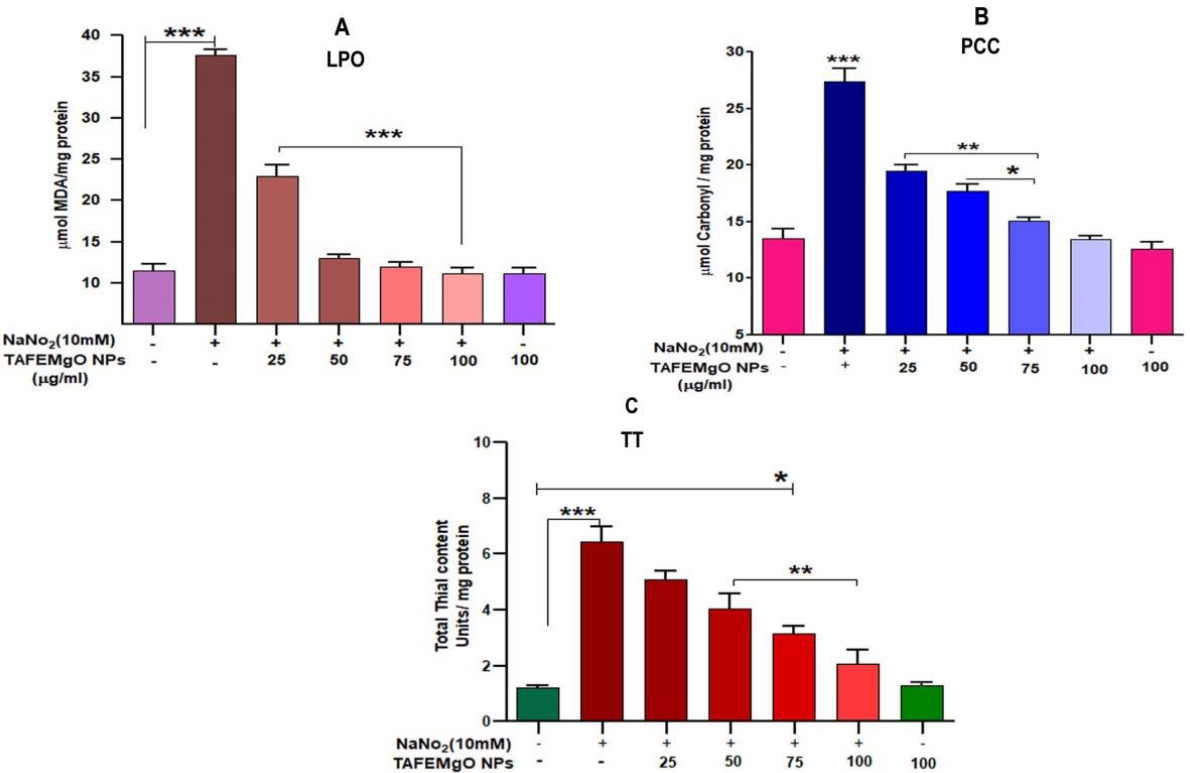
Figure 4. Effect of TAFEMgO NPs on NaNO 2 -induced oxidative stress in RBCs: ( A ) lipid peroxidation, ( B ) protein carbonyls ( C ) total thiols. To determine the mentioned activities of TAFEMgO NPs against NaNO 2 -induced oxidative damage, RBCs were pre-incubated for 10 min with various doses (25–100 g/mL) of TAFEMgO NPs at 37 ◦ C prior to treatment with NaNO 2 (10 mM). The results were presented in average units/mg of protein and were expressed as mean ± SEM ( n = 3). * Significance at p ≤ 0.005, ** at p ≤ 0.001 and *** at p ≤ 0.0001.